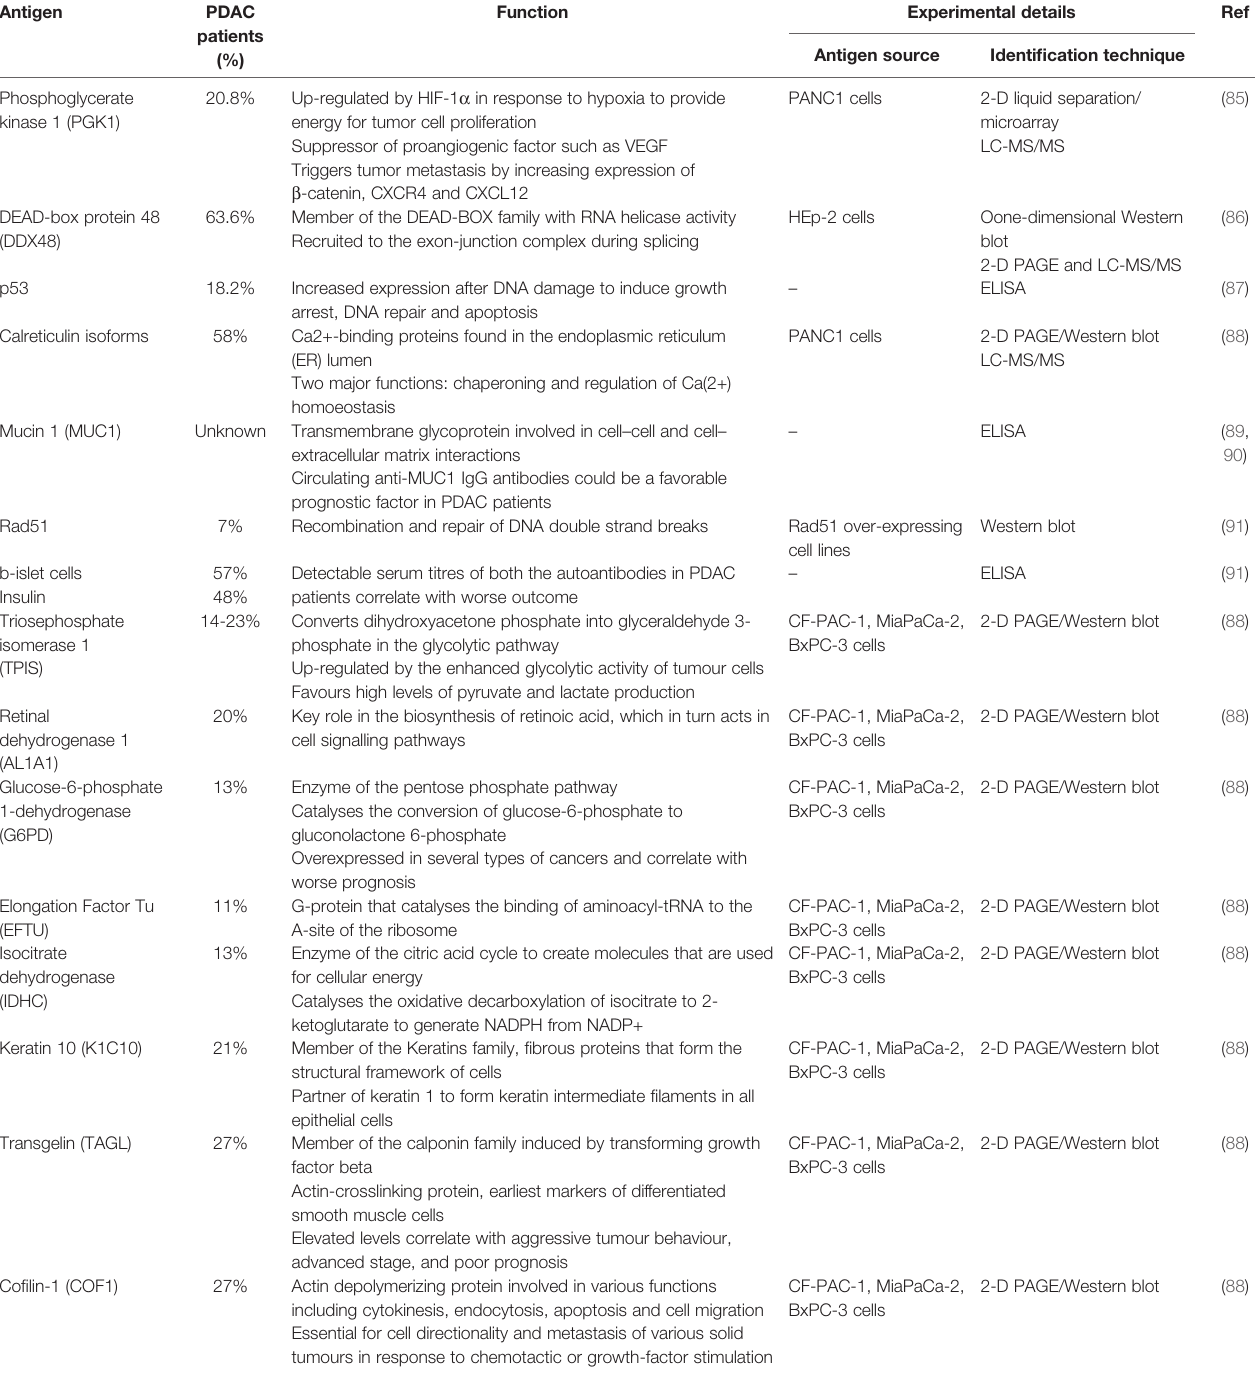
TABLE 1 | Tumour associated antigens in pancreatic